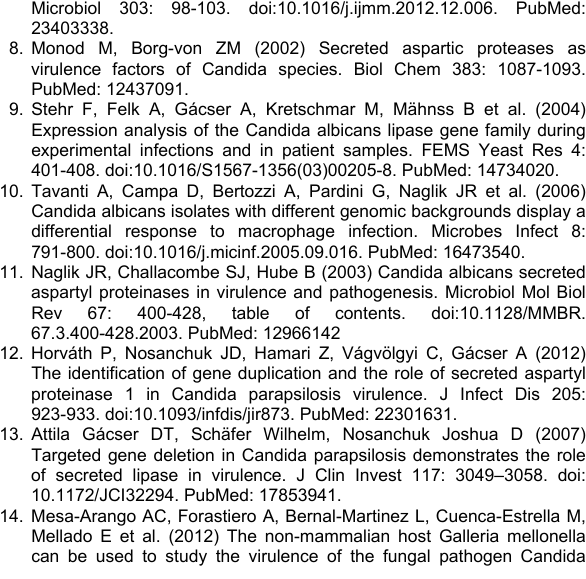
Table S1. List of isolates used in the study. Extracellular enzyme activity and pseudohypha production of the